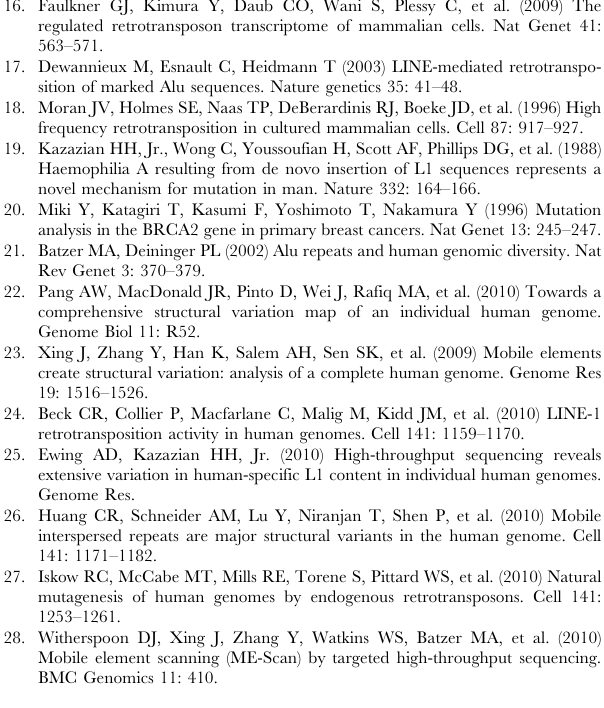
counted. A random placement model is used to estimate the number of expected insertions in the absence of selection. a) MEI counts. b) The corresponding counts of SNPs from the low coverage pilots are also listed along with the expected numbers of SNPs based on random placement. The suppression factor for MEI ( , 46 6 ) is similar to that of a SNP changing a stop codon ( , 42 6 ). (XLSX) Table S11 Mobile element consensus sequences (external Excel file). Repbase element names and sequences for each of the element added to the reference genome for MEI insertion detection. (XLSX) Text S1 The 1000 Genomes Project Consortium. (DOC) Text S2 Supporting Methods.